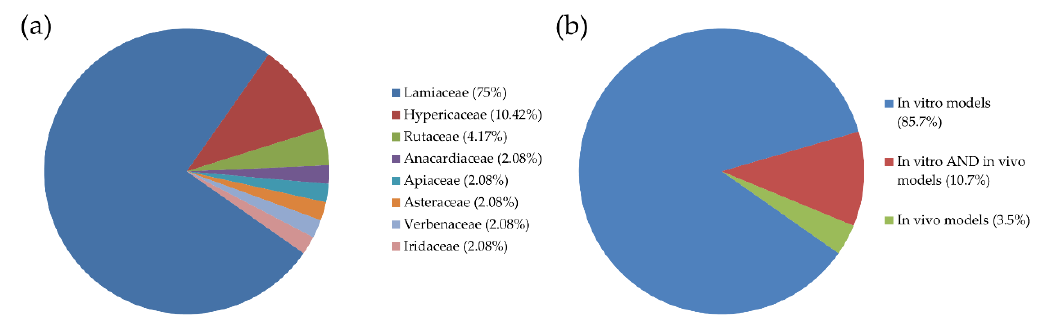
Figure 1. ( a ) The percentage of plant families of the species studied for their antiproliferative activity. ( b ) The percentage of studies on aromatic plant extracts performed in (i) in vitro models, (ii) in vitro and in vivo models, or (iii) only in in vivo